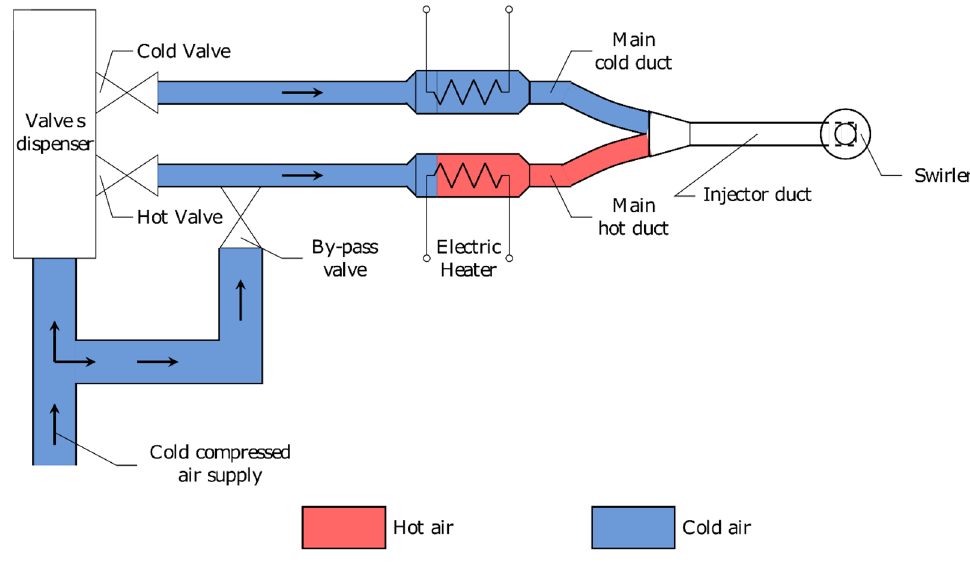
Figure 1. Entropy wave generator (EWG) schematic.